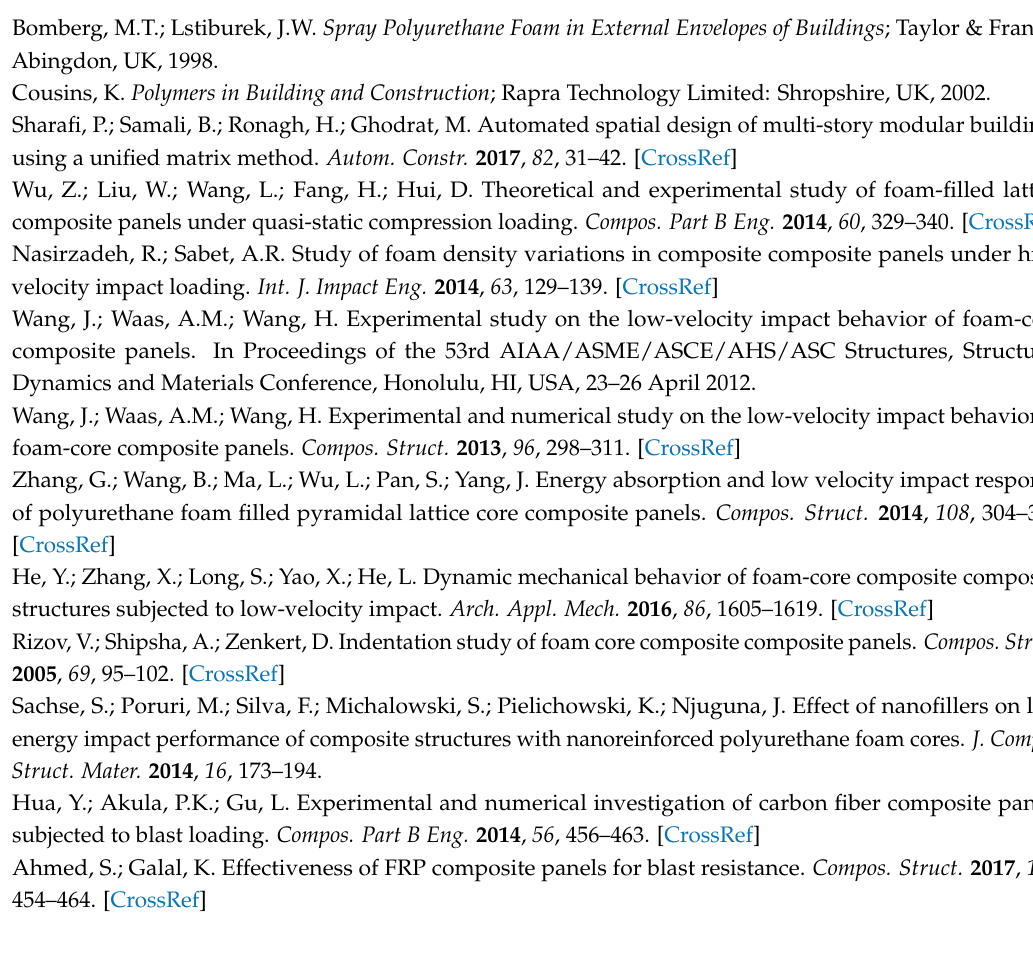
panels from 1998 to 2017.